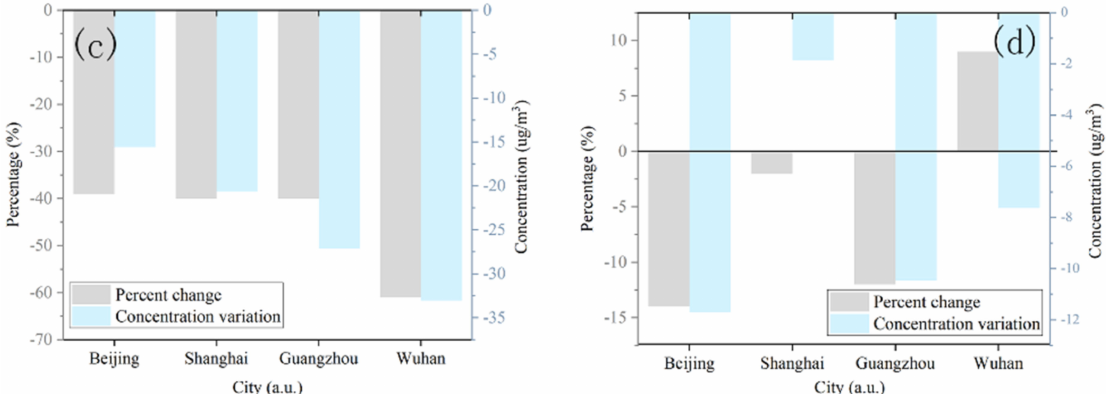
Figure 8. Percentage and concentration changes for O 3 and NO 2 for the four study areas, respectively. In ( a , b ), the maximum monthly averaged concentration changes of NO 2 and O 3 are shown form satellite observation, respectively. In ( c , d ), the maximum monthly averaged concentration changes of NO 2 and O 3 are shown from ground monitoring stations,